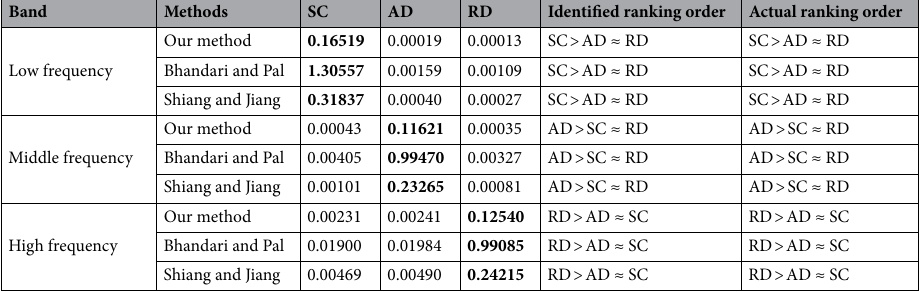
Table 9. Computation of FCE measure values between the fuzzy sets of artificial winding defects (SC, AD and RD) and healthy condition in pre-defined frequency bands. Significant values are in